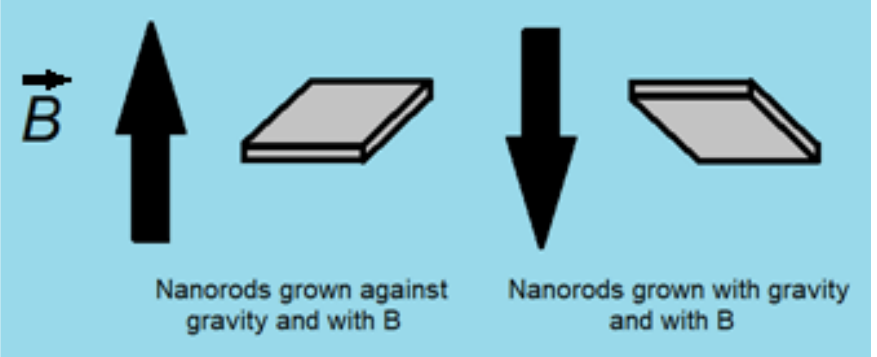
Figure 1. Experimental setup used for ZnO rod growth. All samples discussed in this article were synthesized against gravity unless otherwise specified.